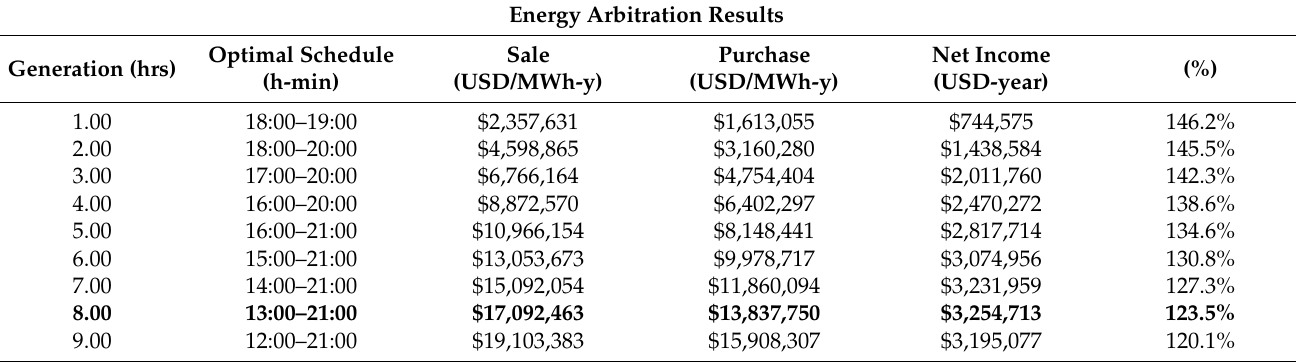
Table 9. Power Arbitrage Optimized Operation.